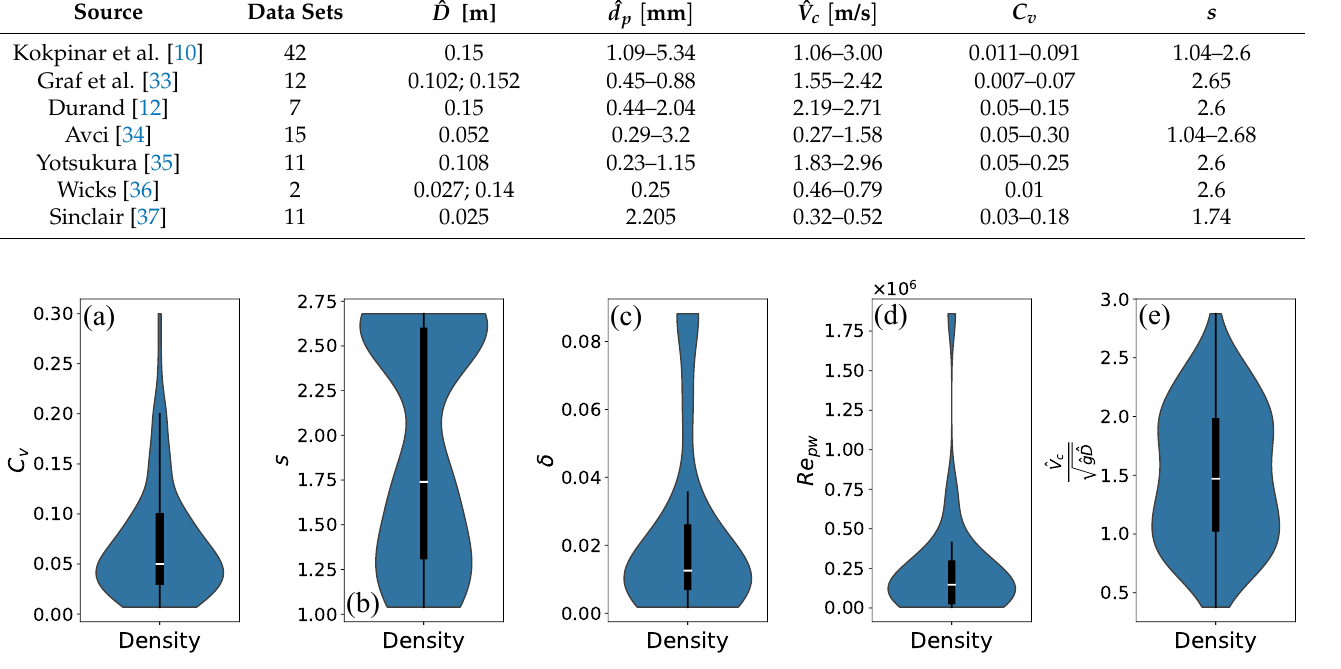
Figure 5. Kernel density distribution and a box plot of all the input features ( C v , s , δ , Re pw ) and the output ( ˆ V c √ respectively) for the critical velocity prediction